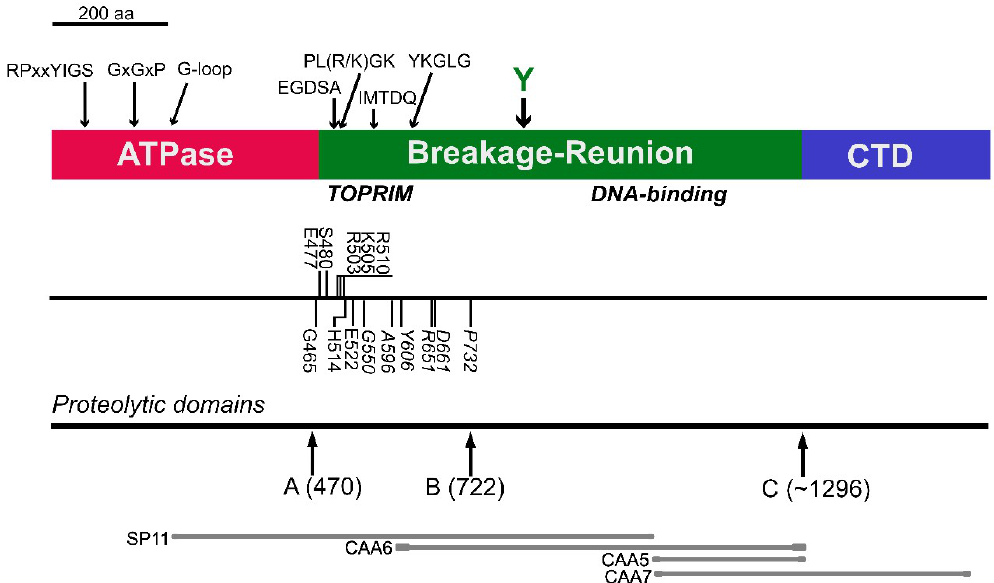
Figure 1. Schematic representation of the domain arrangement of human topoisomerase IIβ. The ATPase domain is shown in red, the breakage-reunion domain in green and the C-terminal domain in blue. The positions of conserved motifs are marked above. The line underneath shows the location of site-directed mutations reported by West et al. [7] (above) and mutations selected for drug resistance reported in Leontiou et al. [8] (below). The locations of inter-domain hinge regions elucidated by limited proteolysis reported in Austin et al. [9] are also shown. At the bottom of Figure 1, the locations of the initial partial cDNA clones encoding portions of TOP2B are shown [5]; SP11, and CAA5, clone CAA6, confirming that CAA5 and SP11 were part of the same gene, are also shown [10,11].